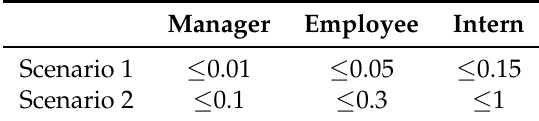
Table 8. Acceptable distance from Current Value (CV) per